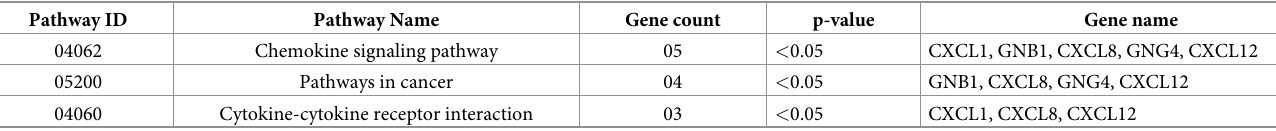
Table 4. Details of the KEGG pathway analysis of the identified real hub genes.